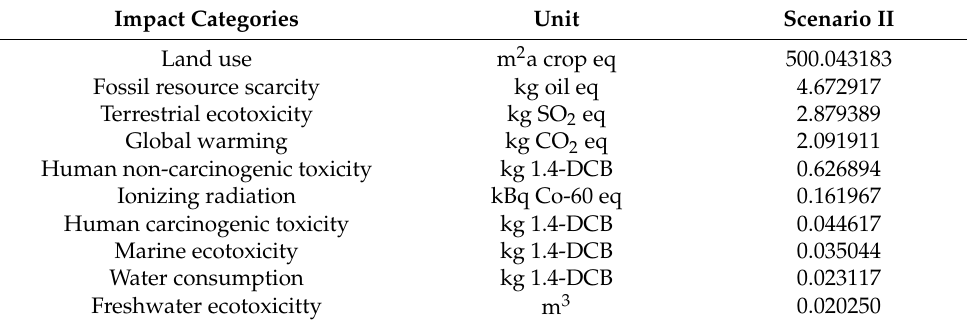
Table 5. Impact categories of the planting process for the Scenario II.